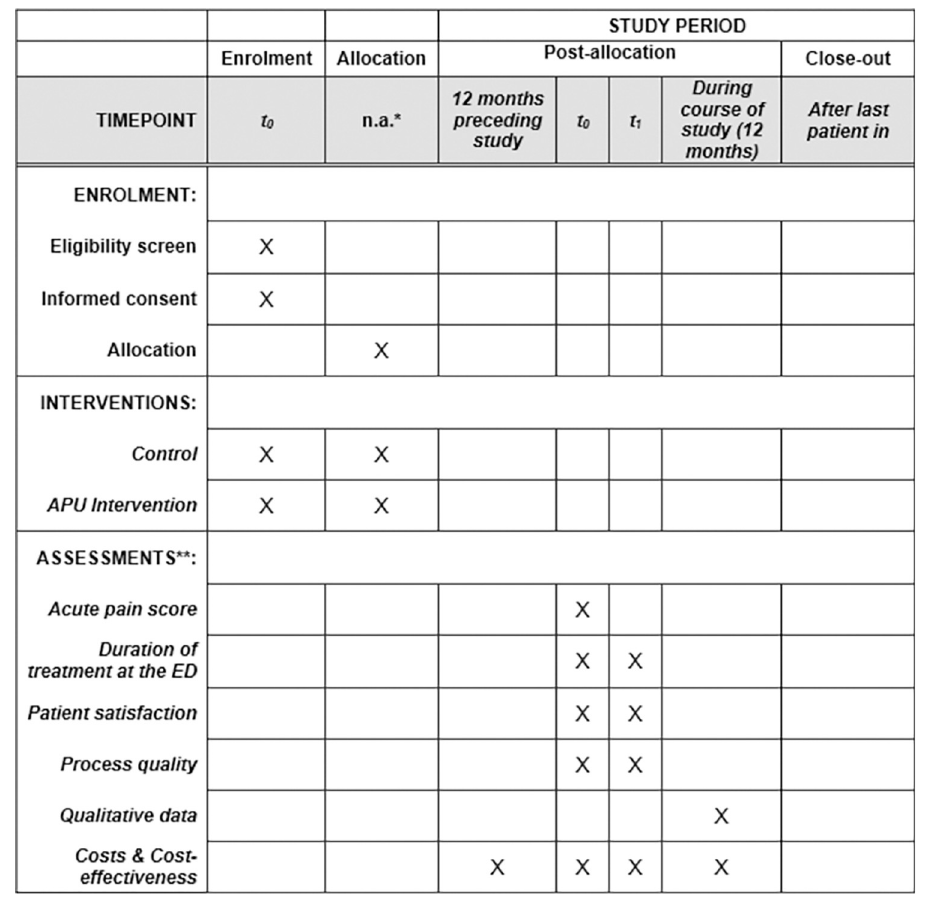
Fig 1. Schedule of enrolment, intervention, and assessments.